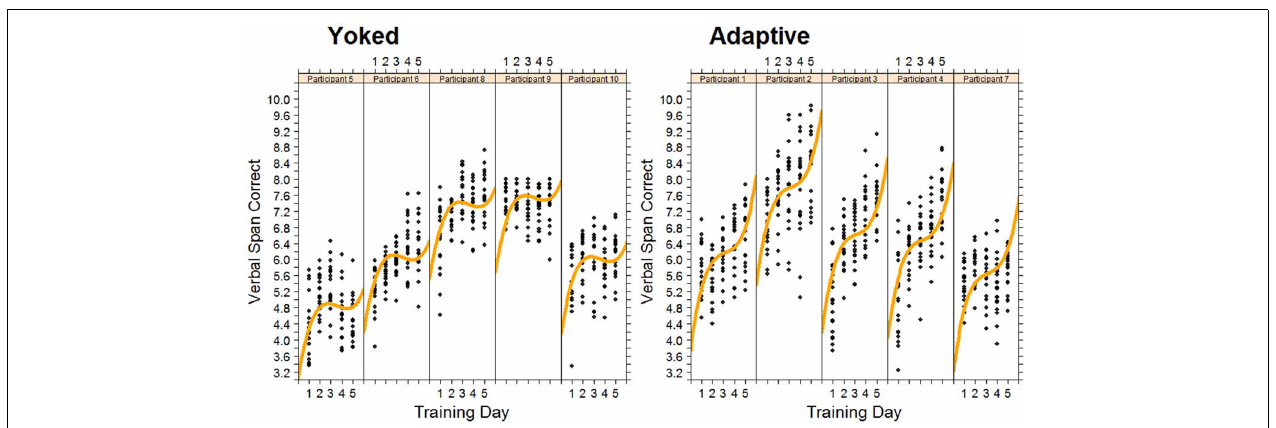
FIGURE 4 | Changes in Verbal span for each trainee in the adaptive training and yoked groups over 5 successive days of working memory training. Each data point represents task performance during a training